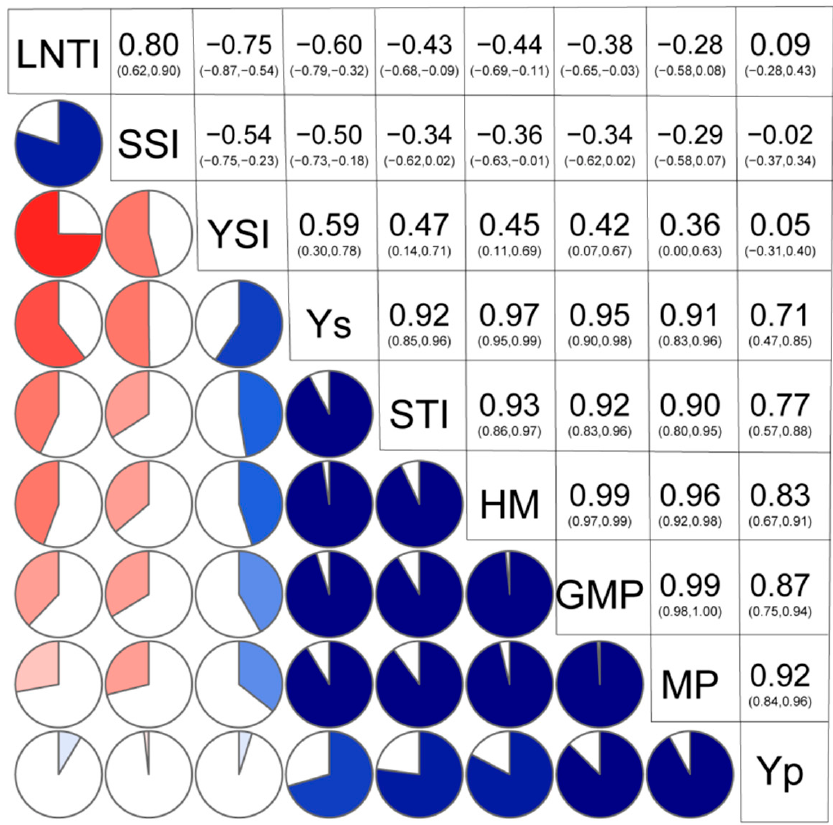
Figure 1. Correlation coe ffi cients and diagram between grain yield ( Yp and Ys ) and seven screening index values for the 31 inbred lines. Data above the diagonal are the correlation coe ffi cients. Data below the correlation coe ffi cients are the confidence intervals. The pie charts below the diagonal indicates the correlation size. The blue color in the clockwise pie charts indicates that the two variables are positively correlated, and the red color in the counterclockwise pie charts indicates that the variables are negatively correlated.